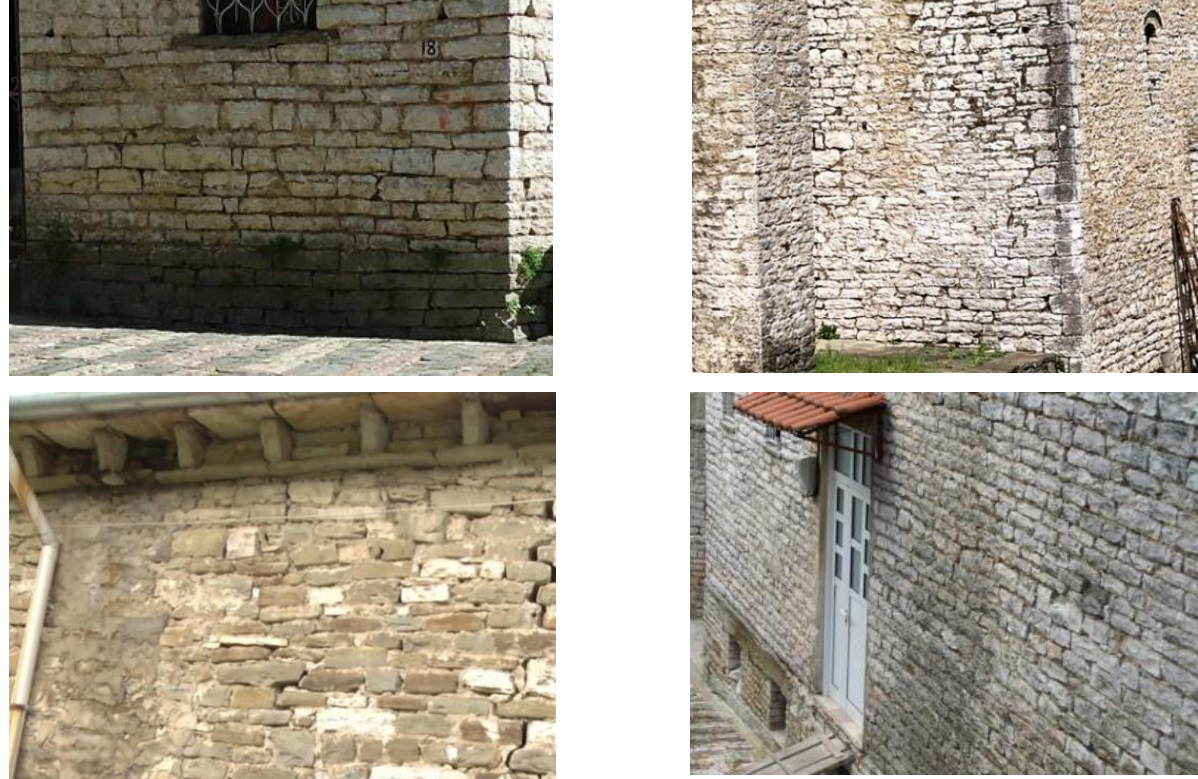
Figure 15. Typical stone walls of Gjirokastër.